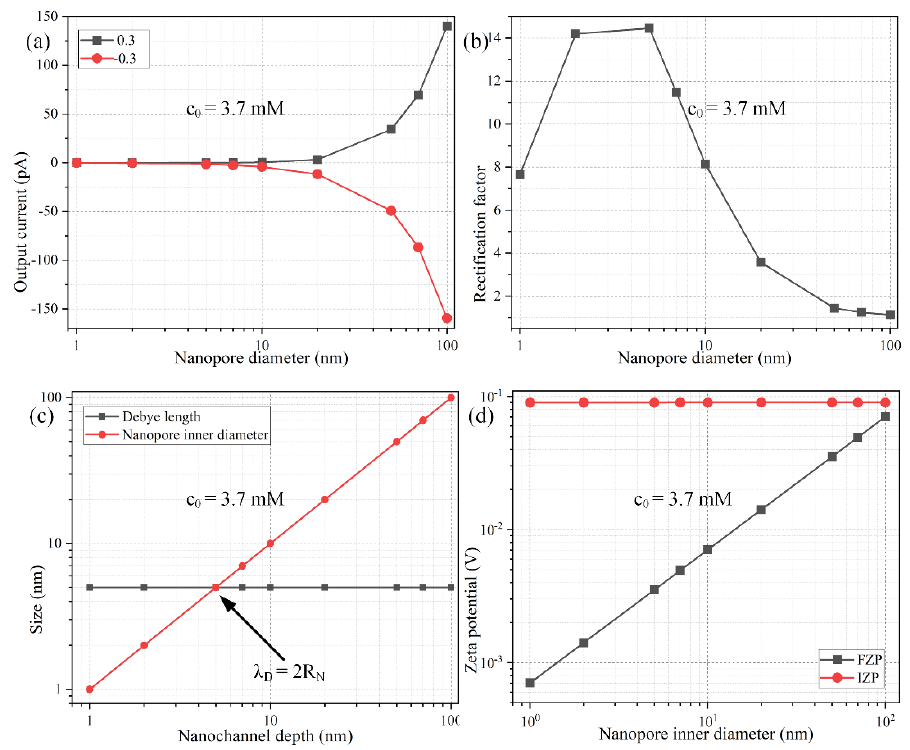
Figure 9. E ff ect of the nanopore inner diameter on the performance of ionic current rectification of the metal-dielectric ion-selective nanopore, under a given parametric space of V S = ± 0.3 V, L C = 600 nm, σ free = − 0.001 C / m 2 , and c 0 = 3.7 mM. ( a ) The forward and backward output ionic current and ( b ) the rectification performance as a function of the nanopore inner diameter. ( c ) A comparison of the Debye screening length with nanochannel depth for varying lateral dimension of the Janus nanopore. ( d ) Analytical approximation of FZP and IZP as a function of the nanopore inner